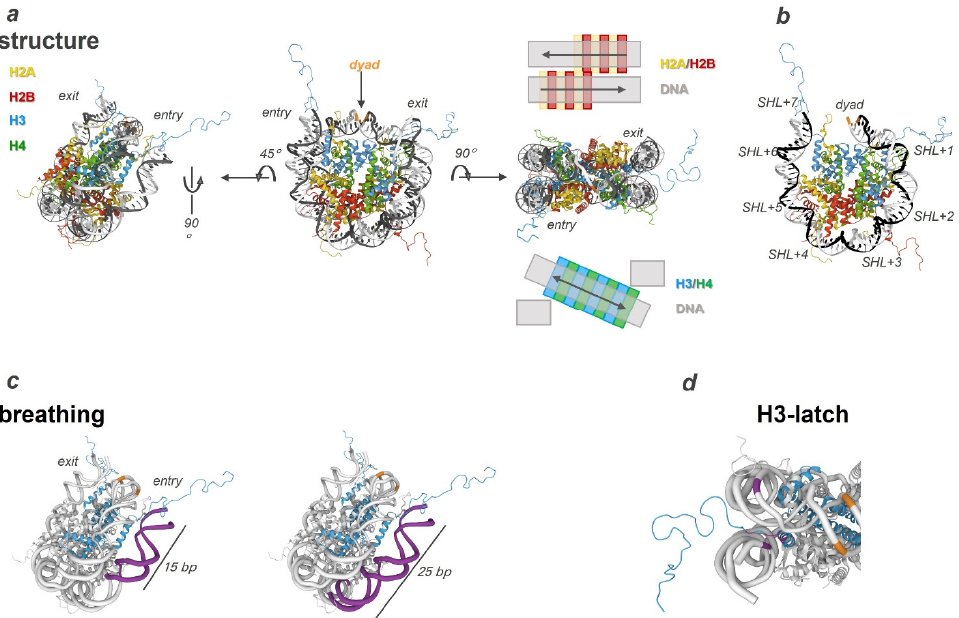
Figure 1. NCP structure and the key compaction factors. ( a ) The following elements of the core particle are highlighted in the image (Protein Data Bank (PDB) ID: 1KX5): DNA strands are grey and white, histones H2A are yellow, H2B is red, H3 is blue, H4 is green, and the dyad base pair is orange. All components are shown in cartoon representation. The side opposite to the dyad (bottom panel). The middle part is schematic representation of the histone dimer’s location relative to the DNA duplex in the NCP structure on the dyad side (upper panel) and on the opposite side (lower panel). ( b ) Cartoon representation of approximately half of nucleosomal DNA, in which superhelical locations are indicated clockwise in DNA from the dyad base pair to the duplex end. ( c ) The spontaneous fluctuations of nucleosome DNA gyres affect the compaction degree as seen on the DNA side [23]. ( d ) Specific contacts of the N-tail of H3 with DNA near the entry/exit site, a so-called latch. The amino acid residues and heterocyclic bases involved in the interaction are highlighted in purple, histone H3 in blue, the dyad in orange, and the other components in white [23].